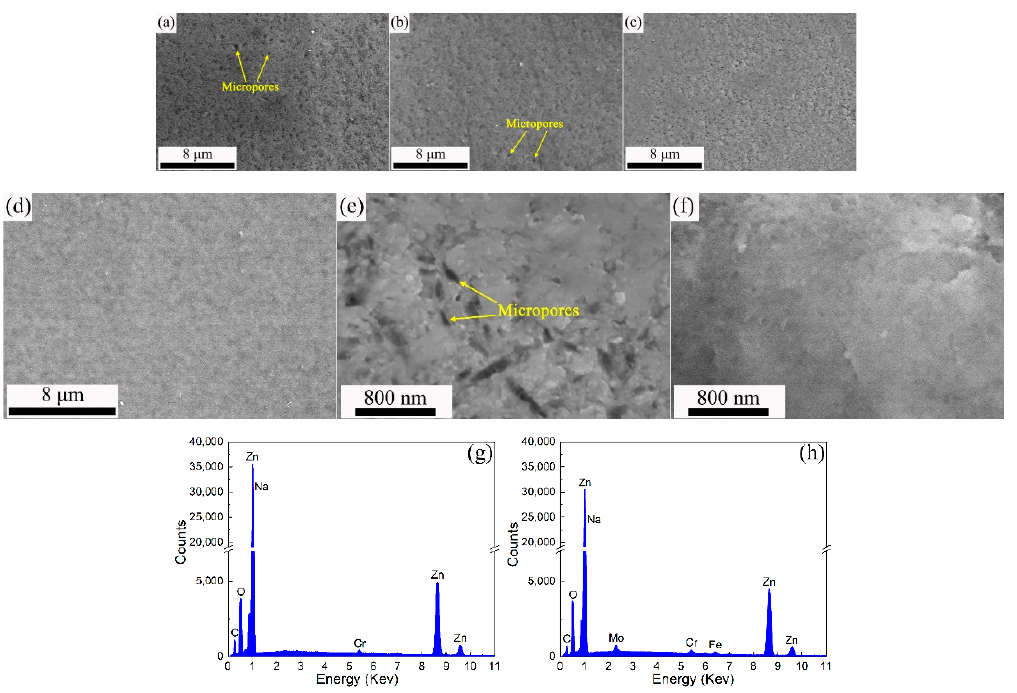
Figure 1. SEM images of: ( a ) ZC; ( b ) ZFC; ( c ) PZC and ( d ) PZFC, ( e , f ) are the magnified view of ( c , d